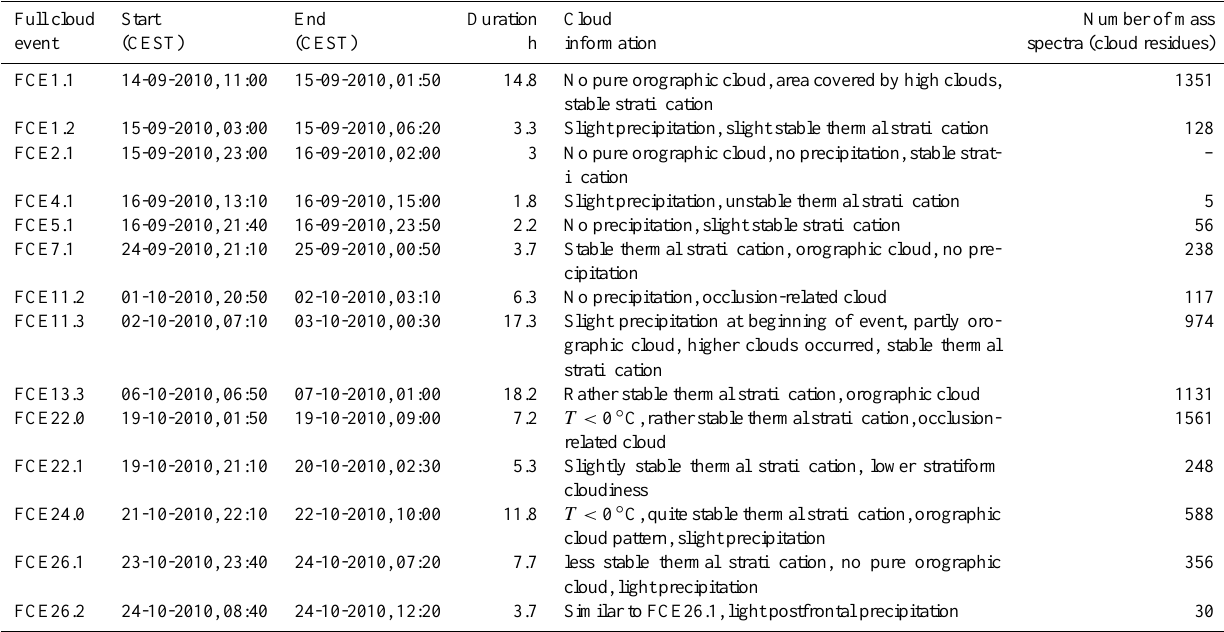
Table 1. Overview of the defined FCEs after Tilgner et al. (2014) during HCCT-2010 and the number of obtained single particle mass spectra by ALABAMA. FCE2.1, FCE4.1, FCE5.1, and FCE26.2 are statistically not